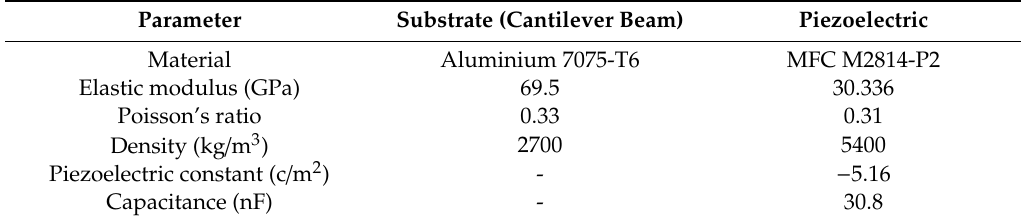
Table 1. Material properties of multiresonant